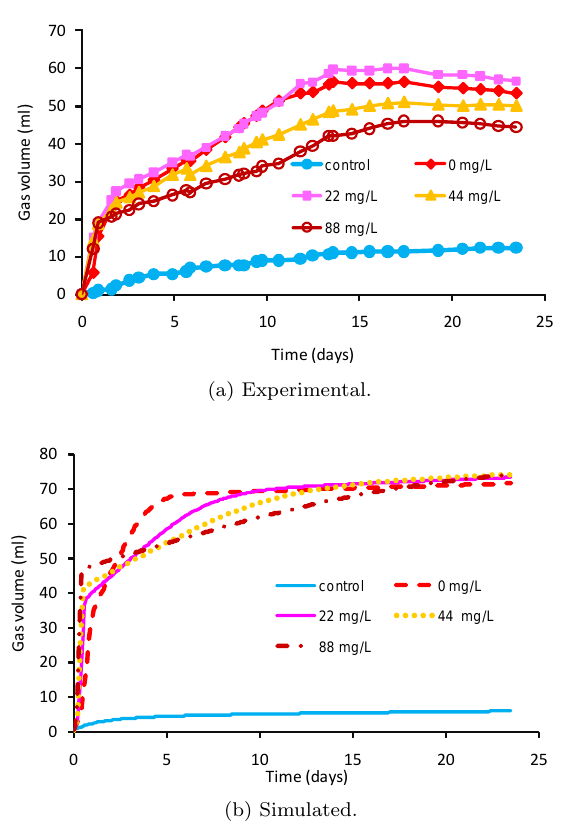
Figure 1: Experimental (a) and simulated (b) total cu- mulative gas generation for the control and for different oxygen loading conditions.